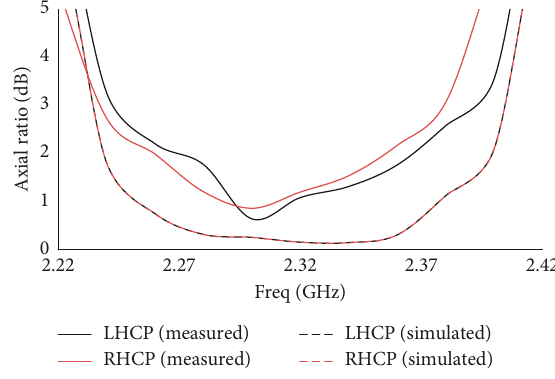
Figure 7: Axial ratio vs.